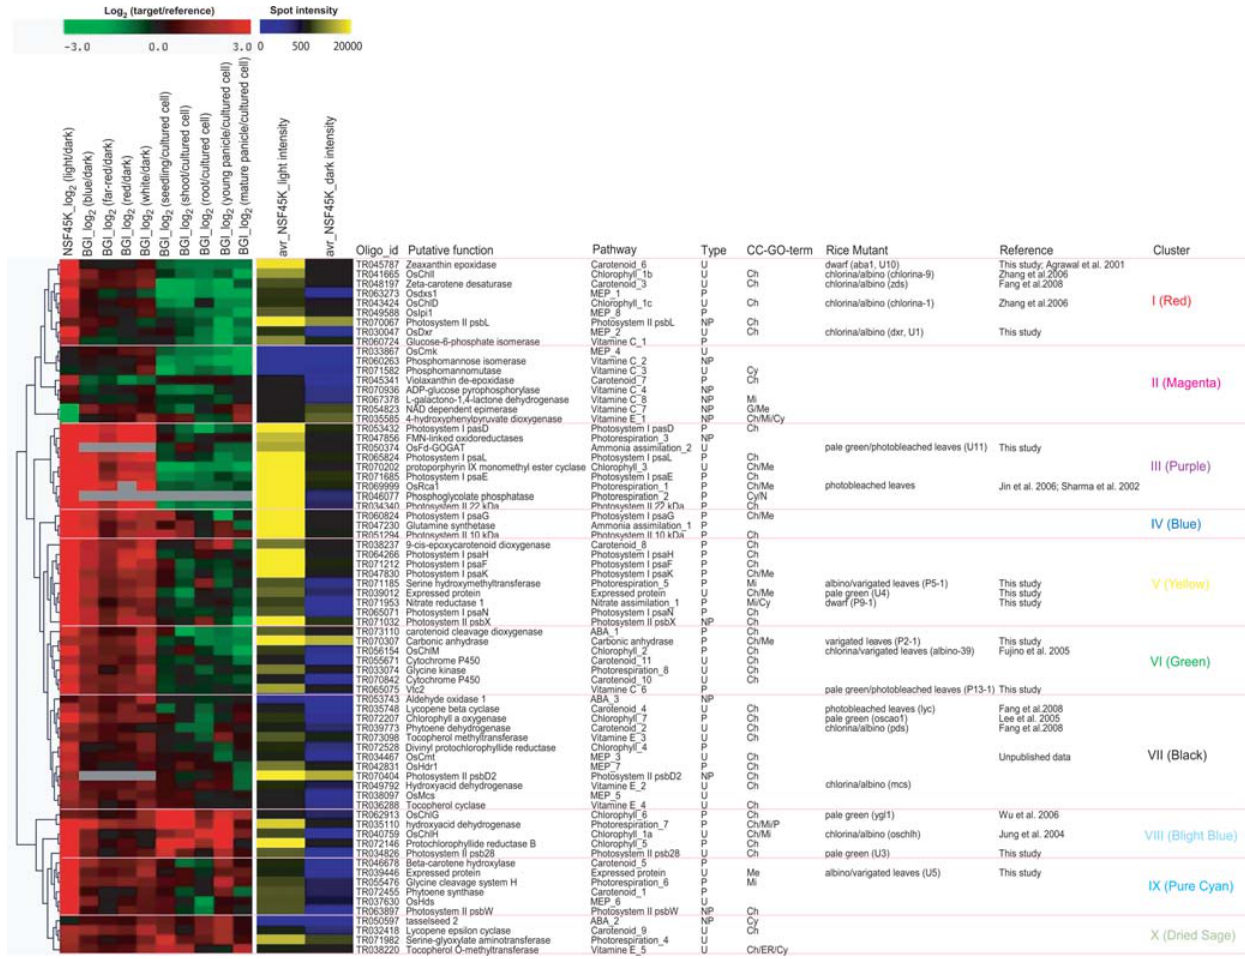
Figure 4. Co-Expression Analysis of 72 Genes in the Pathways Related to 10 Mutants Identified in This Study. Hierarchical clustering analysis was carried out for 72 genes related to the 10 mutants shown in Figure 3; cluster results are indicated on the far left side of this figure. In the left panel, the log 2 fold change values of the 10 datasets used to perform hierarchical clustering analysis are shown (for details of the 10 datasets and how they were analyzed see Materials and Methods). The middle panel indicates the average of all spot intensities for an oligo in the light (av_NSF45K_light intensity) and dark (av_NSF45K_dark intensity) from NSF 45K light vs. dark datasets as another indicator of gene expression levels. Oligo_id indicates the name of the oligos in NSF45K array; Putative function describes the annotation assigned to that gene; Pathway indicates the biochemical pathway and step in the pathway associated with the gene; Type indicates status of the gene in the rice genome: U, unique sequence; P, predominantly expressed gene family member in the light; and NP, not the predominantly expressed gene family member in the light; CC-GO_term, indicates GO terms within the cellular component category; Rice Mutant indicates the phenotype associated with a mutation in the gene; and Reference provides citations to published evidence for the phenotypes described in the previous column. More information regarding U1, U3, U4, U5, U10, U11, P2-1, P5-1, P9-1, and P13-1 is contained in Table 2. In the column labeled CC-GO_term: Ch indicates chloroplast; Cy, cytoplasm; ER, endoplasmic reticulum; Mi, mitochondrion; Me, membrane; N, nucleus; and P, peroxisome. Data used for clustering analysis and more